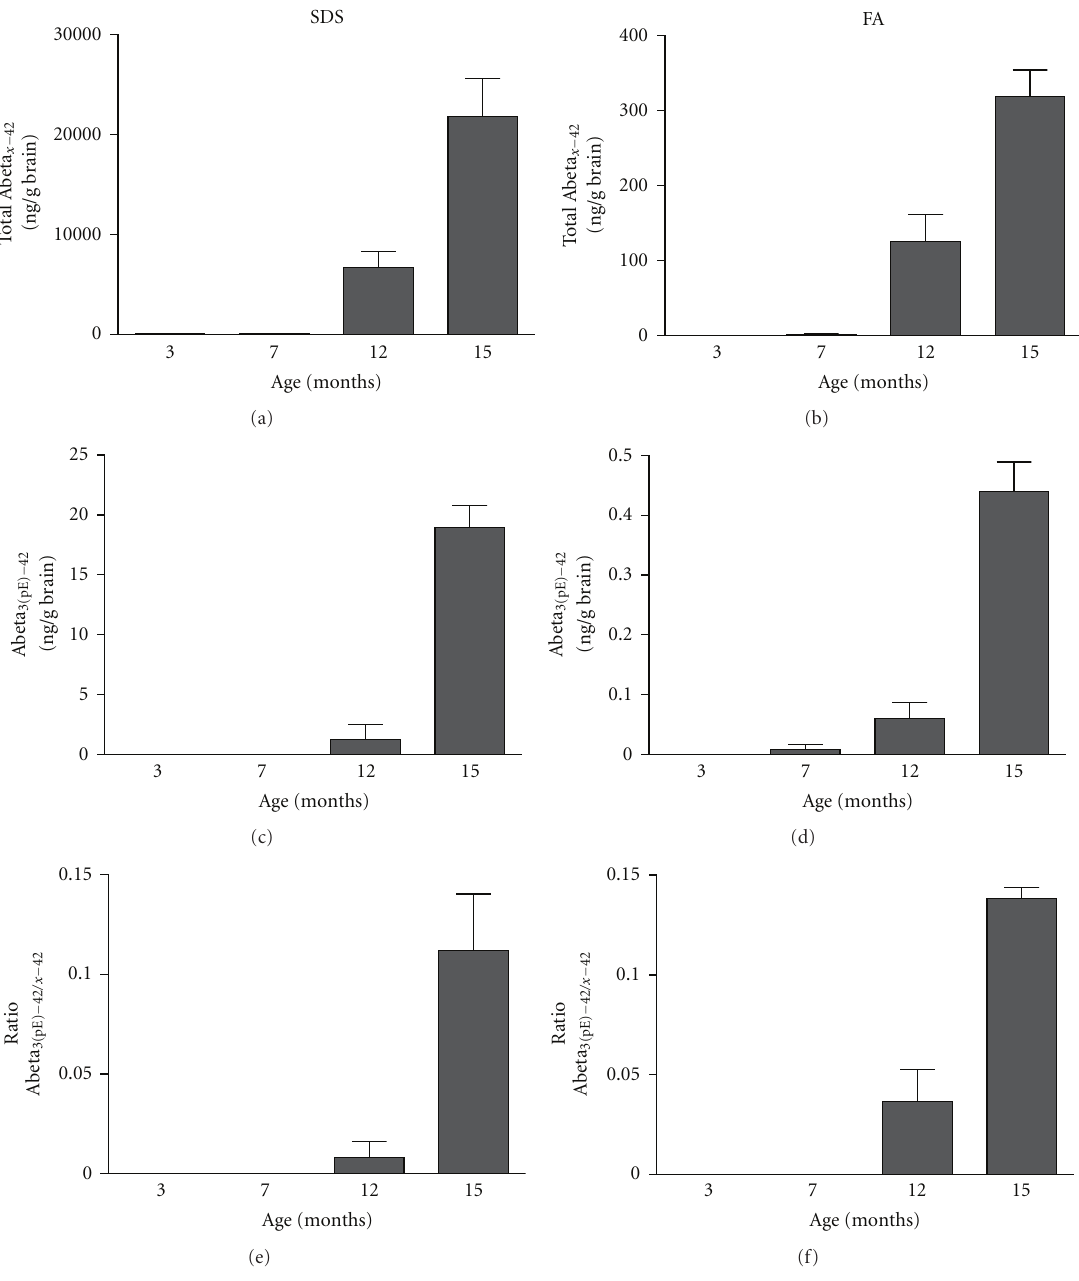
Figure 2: Abeta 3(pE)–42 determination in the SDS and FA extracts of APP-Ld brain. Pan-Abeta42 (a, b) and Abeta 3(pE)–42 (c,d) concentrations in SDS (a, c) and FA (b, d), as well as the corresponding Abeta 3(pE)–42 to pan-Abeta42 ratios (in %) (e, f).